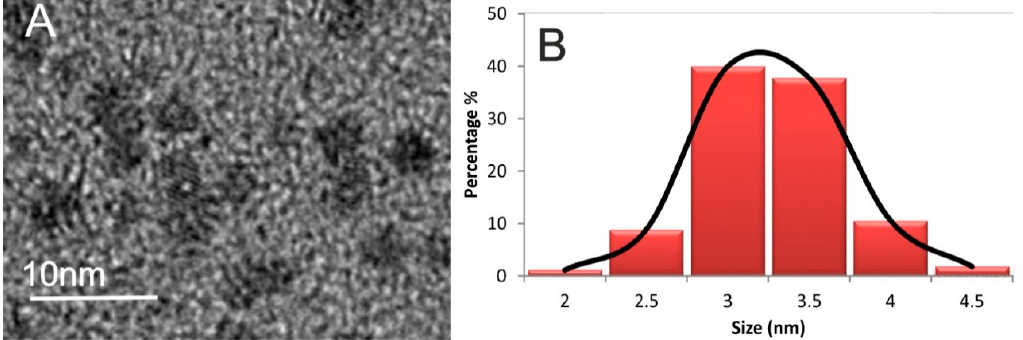
Figure 2. ( A ) TEM image and ( B ) size distribution of the synthesized CNDs-DS.